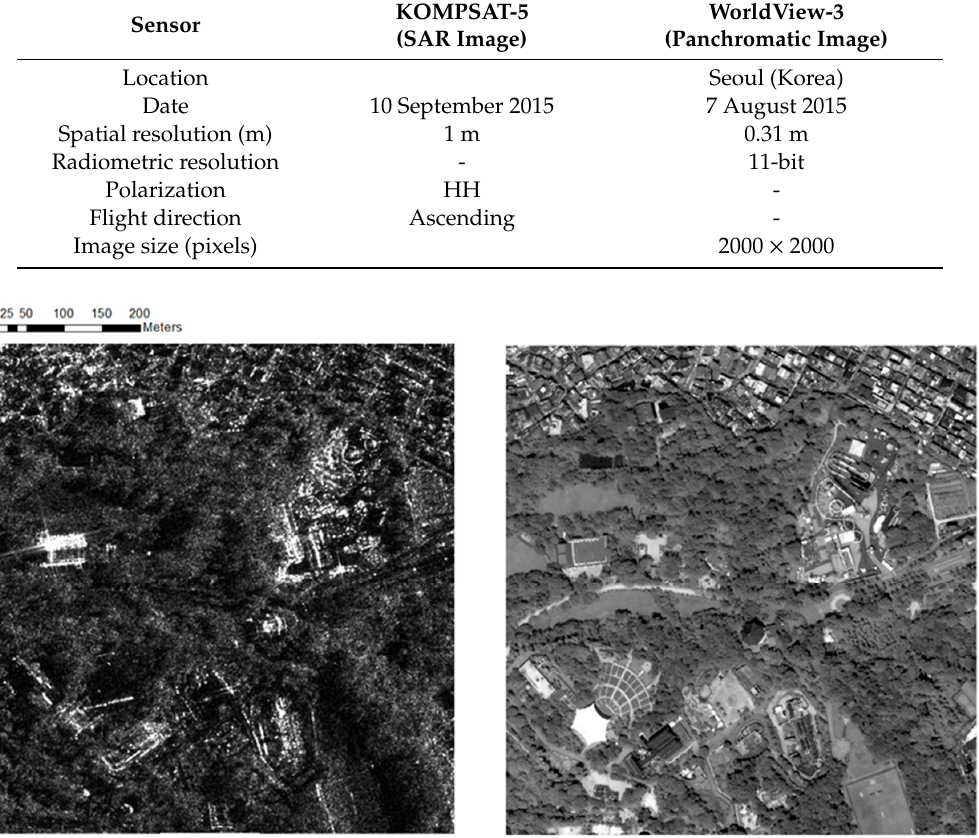
Figure 1. Location of the study area (red outline indicates the study area). Table 1. Specifications of the experimental data (SAR: synthetic aperture radar, HH: horizontal transmit-horizontal receive).